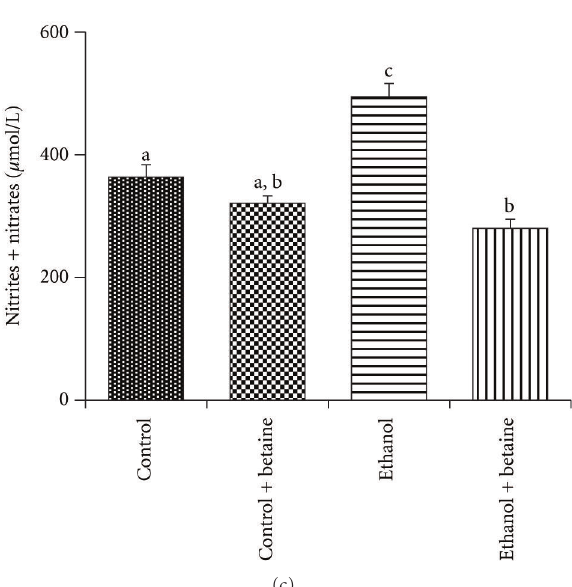
Figure 4: Betaine attenuates chronic ethanol-induced increase hepatic NOS2 gene and protein expression and elevates mitochondrial nitrite/nitrate levels. (a) Liver NOS2 mRNA levels were measured by quantitative PCR using the comparative Ct concentration method. The data shown are mean ± SEM of eight determinations from each group. Values not sharing a common subscript letter are statistically di ff erent, P < 0 . 05. (b) Hepatic NOS2 (130 kDa) protein expression was measured by immunoblotting and normalized to β -actin (45kDa). Representative immunoblots of NOS2 protein for one pair of untreated and one pair of betaine-treated control and ethanol animals is shown. The bar graph results below represent the mean volume integration units (V.I.U) of NOS2 ± S.E.M. for n = 8 animals per group. Values not sharing a common letter are statistically di ff erent, P < 0 . 05. (c) Total mitochondrial nitrite and nitrate levels were measured by the Griess reaction as detailed [26]. The bar graph results represent the mean ± S.E.M. for n = 8 animals per group. Values not sharing a common letter are statistically di ff erent, P < 0 .